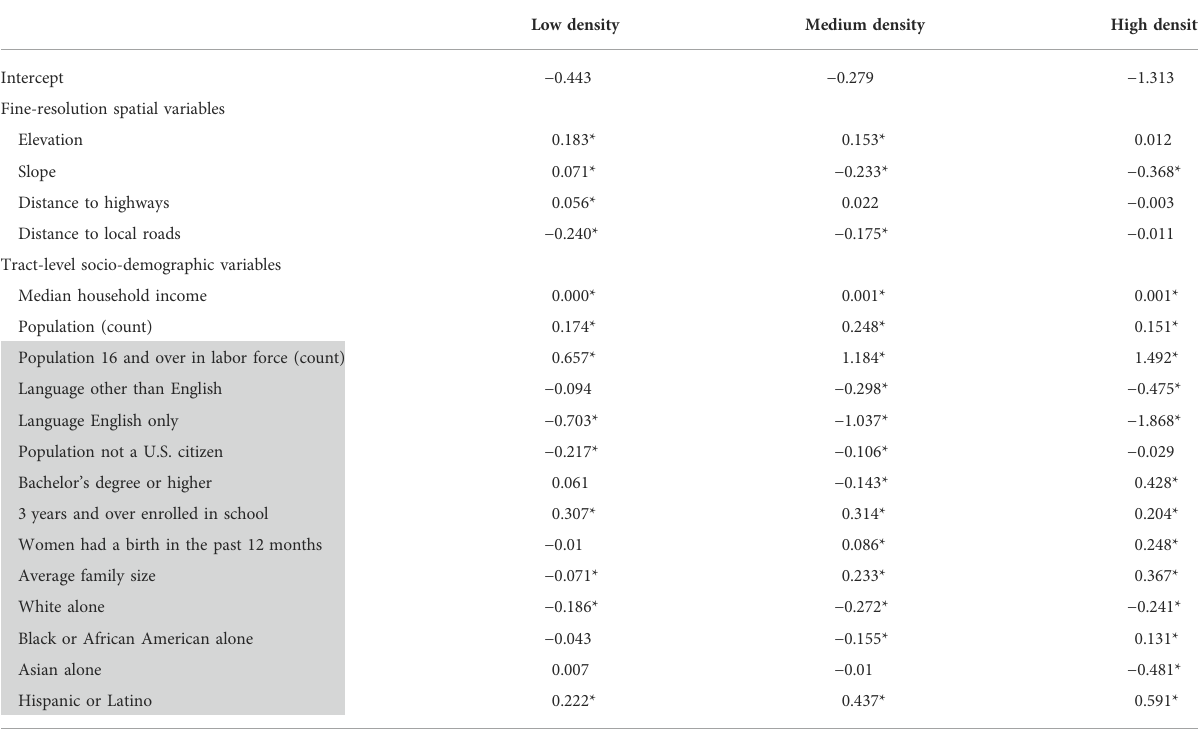
TABLE 2 Coef fi cients of multinomial logistic regression model of urban expansion (changes from non-urban to low-, medium- or high-built-up density